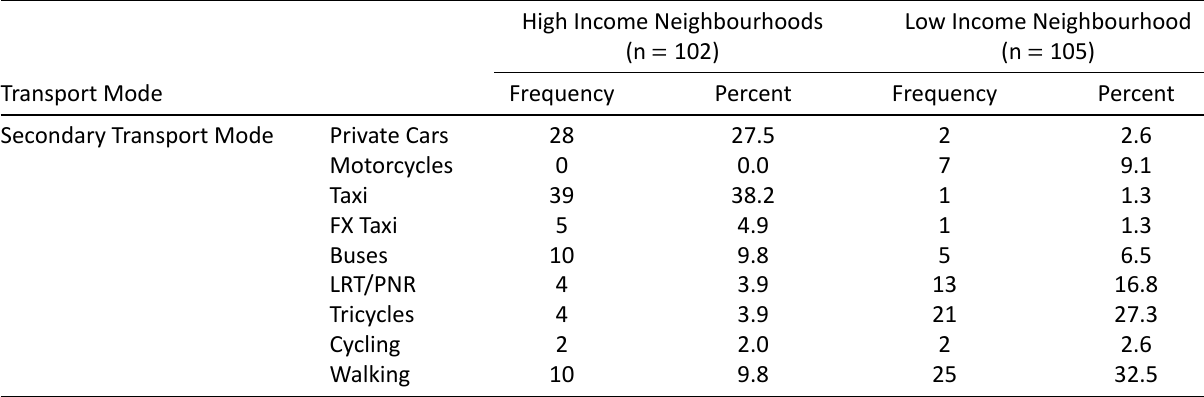
Table 1. Descriptive statistics.